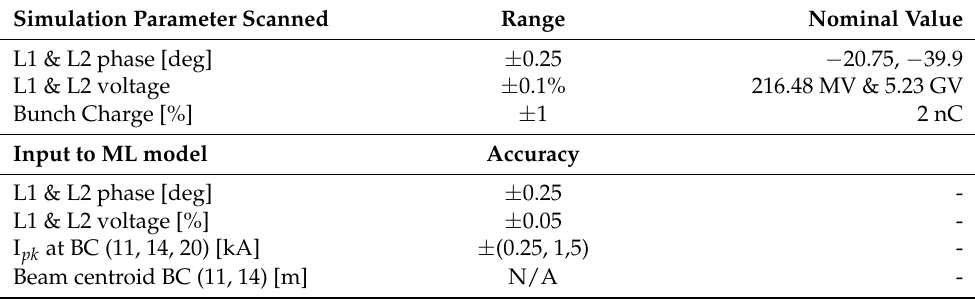
Table 1. Linac and e-beam parameters scanned in the 3125 simulations of the FACET-II accelerator. The ranges are chosen closely based on the jitter parameters from the FACET-II TDR [8]. The diagnostics fed to the ML model include random errors introduced artificially to approximate the measurement accuracy present in the